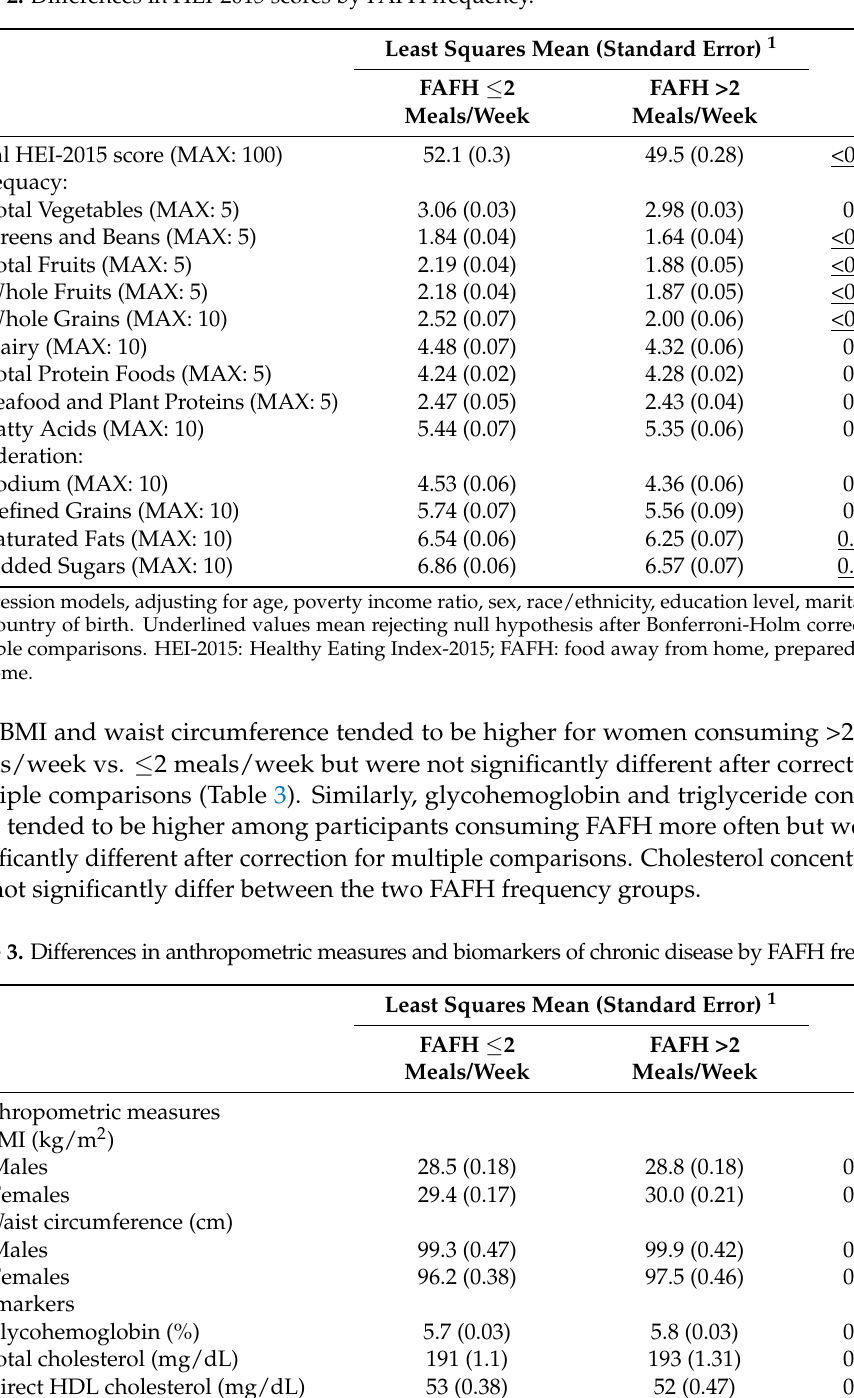
Table 2. Differences in HEI-2015 scores by FAFH frequency.